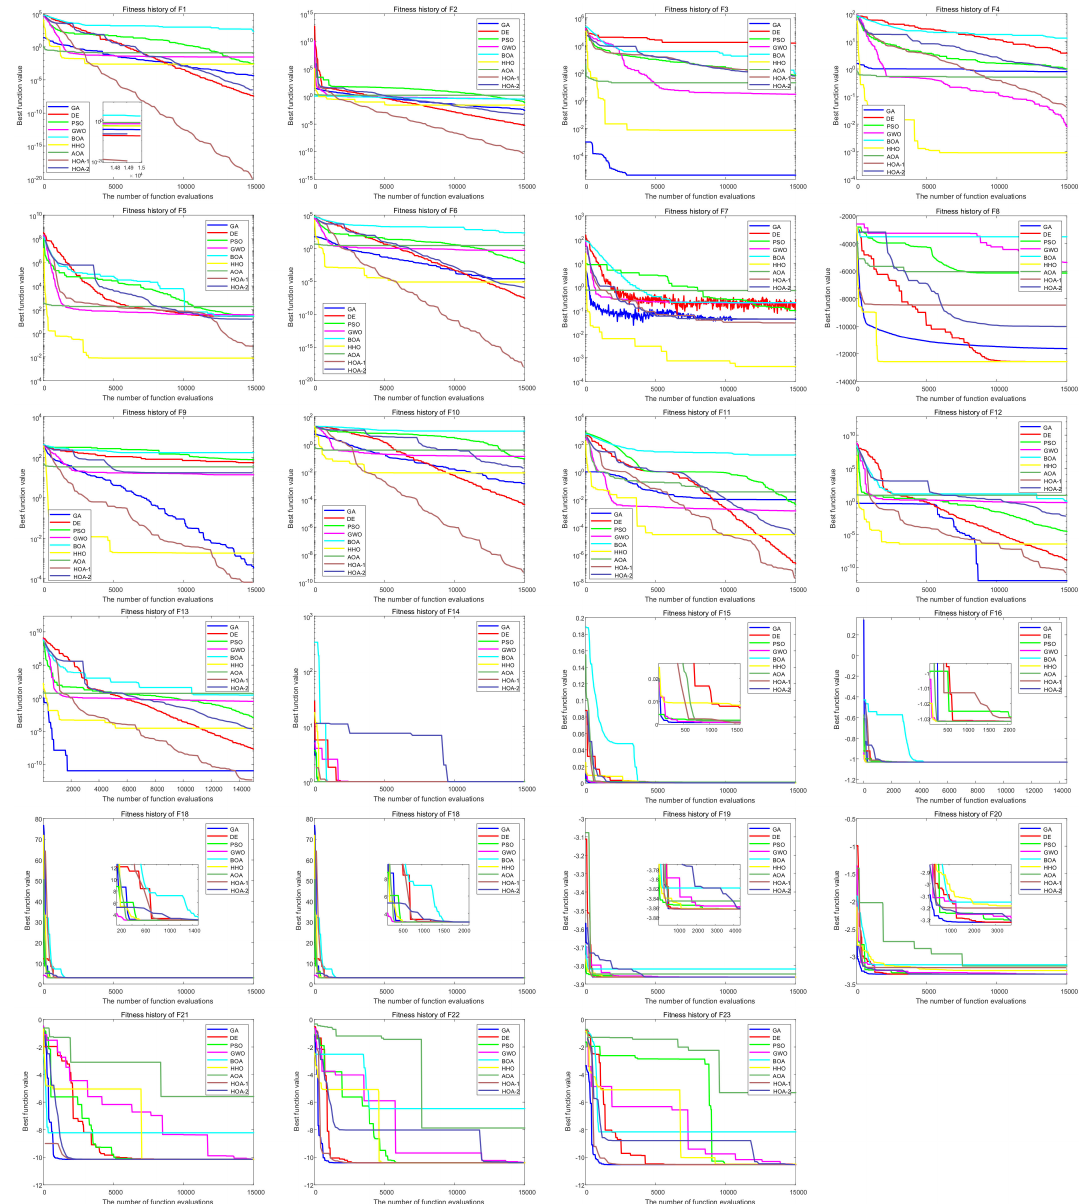
Figure 4. Searching history of benchmark